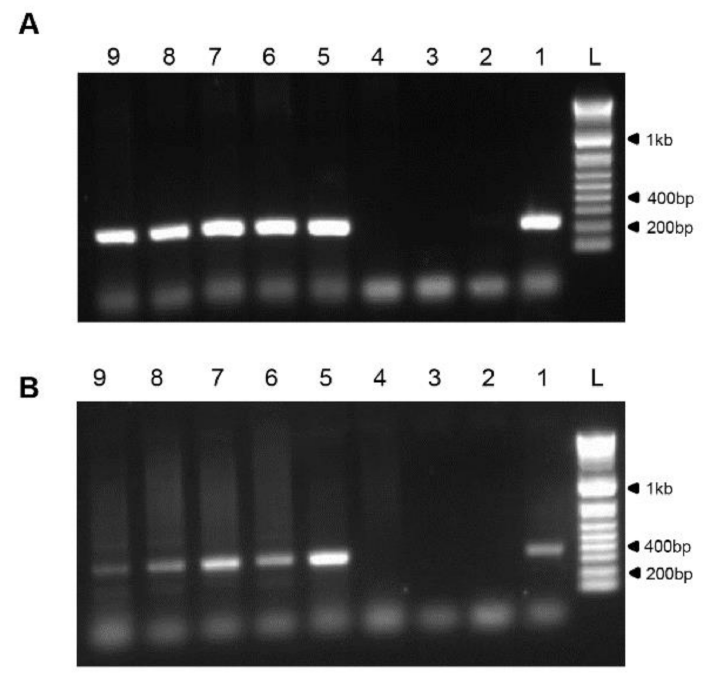
Figure 3. Detection of poxvirus in suckling bats. ( A ) PCR of poxvirus Insulin metalloproteinase-like- IMV region, amplifying 220 bp product. ( B ) PCR of poxvirus DNA-dependent DNA polymerase, amplifying 338 bp product. L- ladder (1 Kb plus DNA ladder, Invitrogen), 1-C+ from IsrRAPXV infected bat (strain 1000/15 (15)), 2- C- PCR mix, 3-C- isolation, 4-C- skin from healthy bat, 5-#1840, 6-#1827, 7-#1375, 8-#1374,